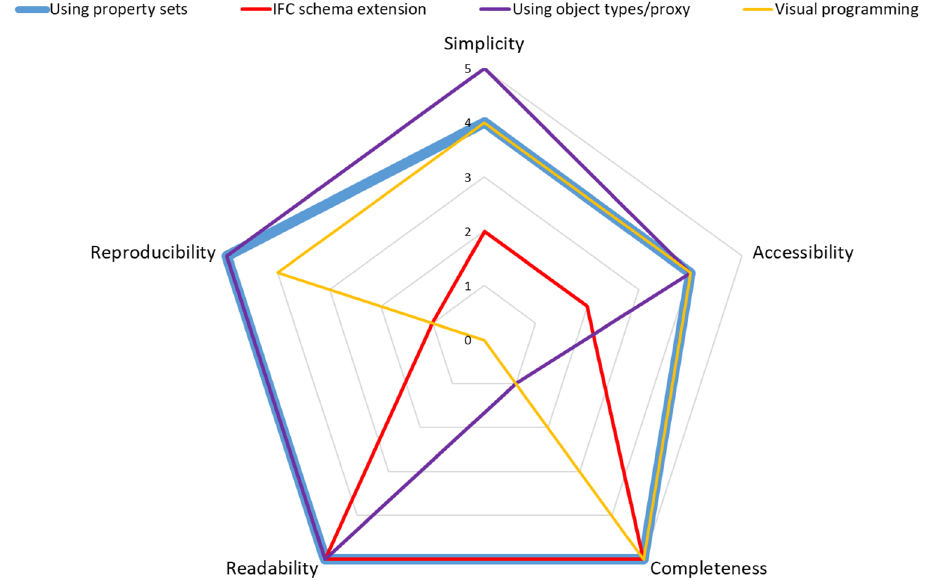
Figure 8. Comparison of IFC modelling and data exchange prototypes in a smart building.